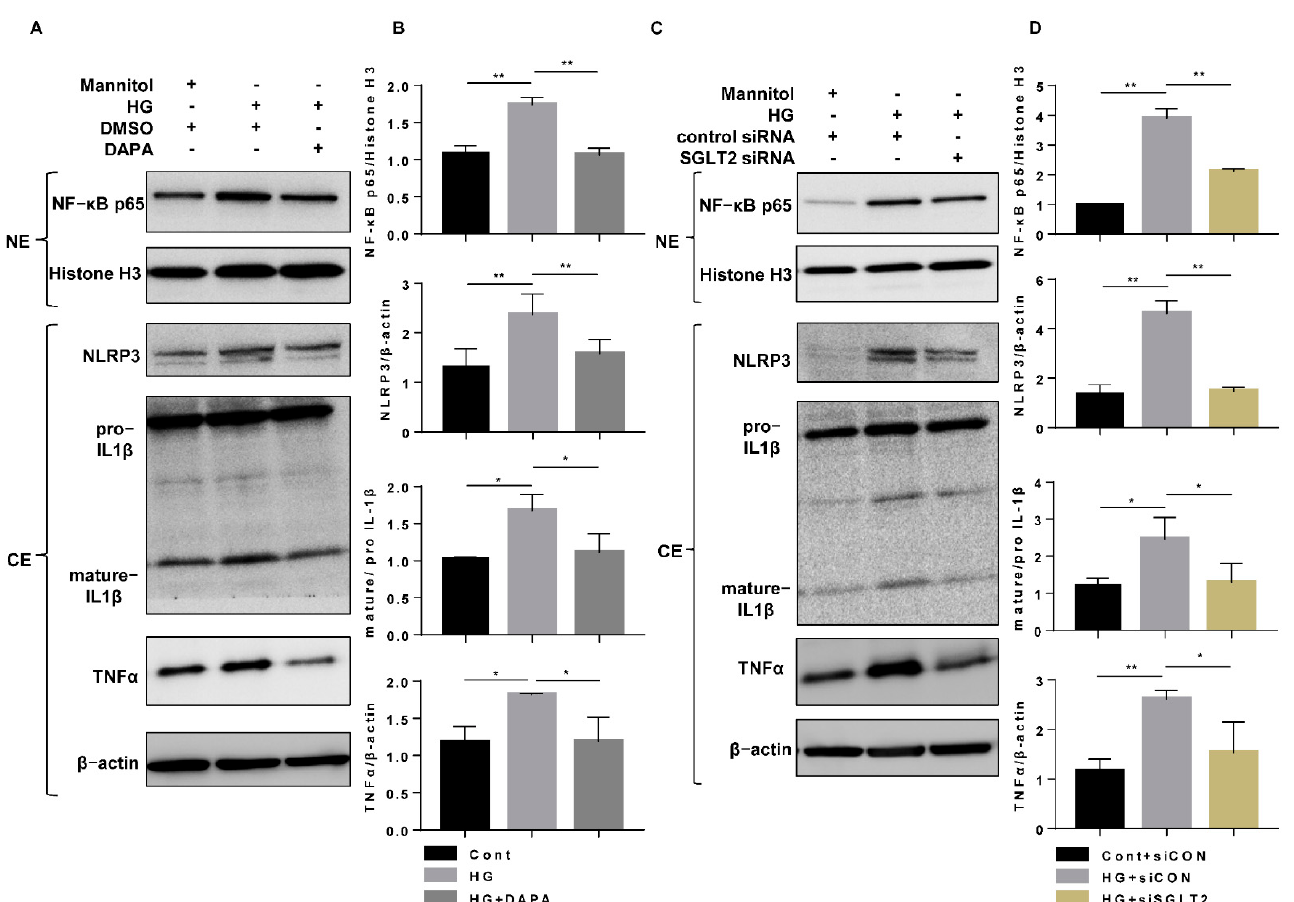
Figure 5. SGLT2 inhibition suppressed HG-induced nuclear localization of NF- κ B p65. ( A ) HK-2 cells were incubated with Cont, HG (30 mM), or HG (30 mM) and dapagliflozin (20 µ M) for 48 h, and the levels of NF- κ B p65 in nucleoprotein extracts and NLRP3, IL-1 β , TNF α in cytoplasmic protein extracts were assessed by western blotting. ( B ) Densitometric evaluation of ( A ) (n = 3). ( C ) HK-2 cells were transfected with SGLT2 siRNA (200 nM) or control siRNA for 6 h and then incubated with Cont or HG (30 mM) medium for 48 h. The levels of NF- κ B p65 in nucleoprotein extracts and NLRP3, IL-1 β , and TNF α in cytoplasmic protein extracts were assessed by western blotting. ( D ) Densitometric evaluation of ( C ) (n = 3). All data represent means ± standard deviation (SD). * p < 0.05 vs. the indicated group, ** p < 0.01 vs. the indicated group (n = 3). Cont, control; HG, high glucose; DAPA, dapagliflozin; siCON, control siRNA; siSGLT2, SGLT2 siRNA; NE, nucleoprotein extracts; and CE, cytoplasmic protein extracts.